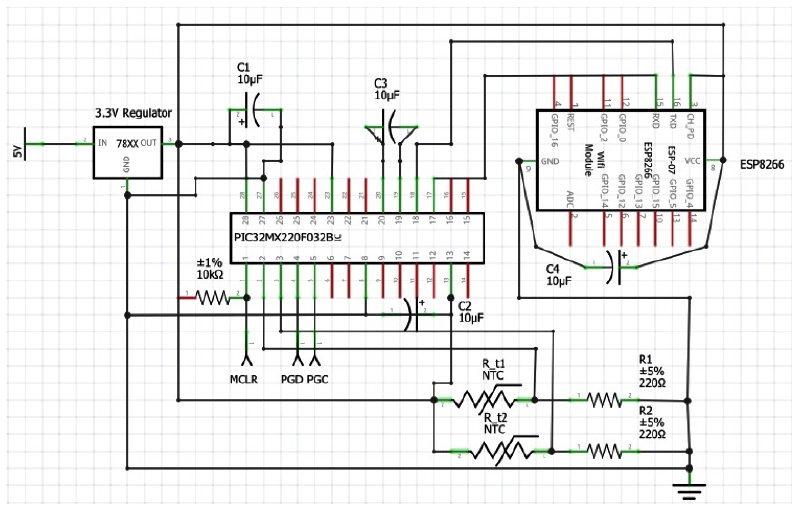
Figure 2. Conceptual design of the virtual sensor